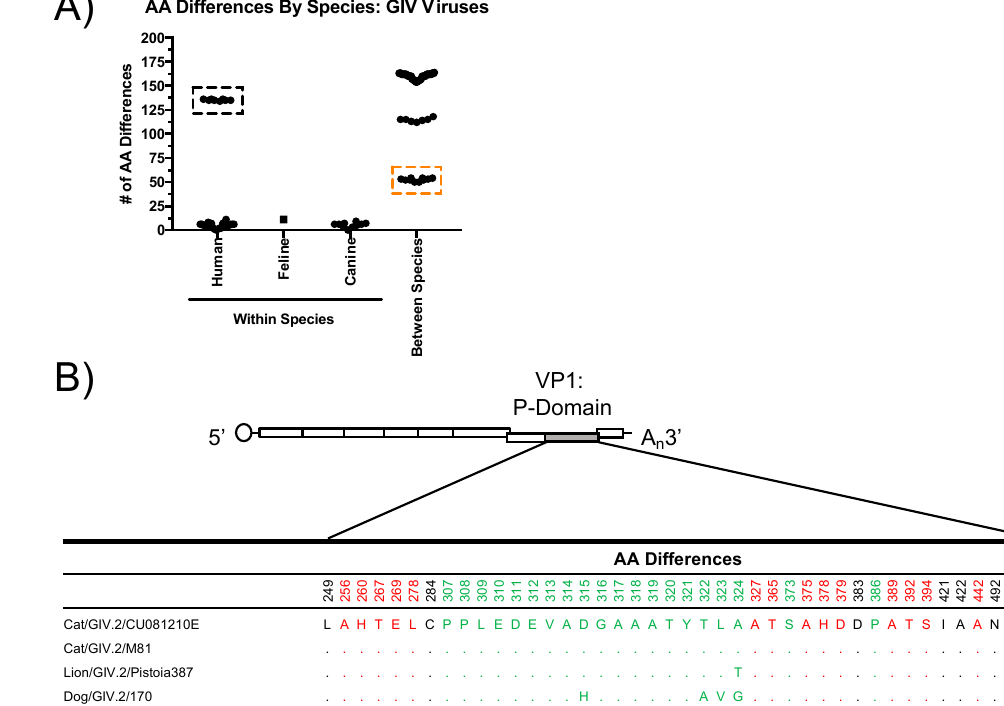
GIV.3 noroviruses (Figure 3B, Table S3). We also aligned all GIV.2 VP1 sequences to compare aa differences between canine and feline viruses (Figure S2A). Twenty-one out of 26 (80.8%) of the residues were located on the surface of the P-domain (Figure S2B). Taken together, the VP1 proteins of canine and feline norovirus contain multiple surface-exposed differences and a large insertion that differentiates them from the human norovirus VP1